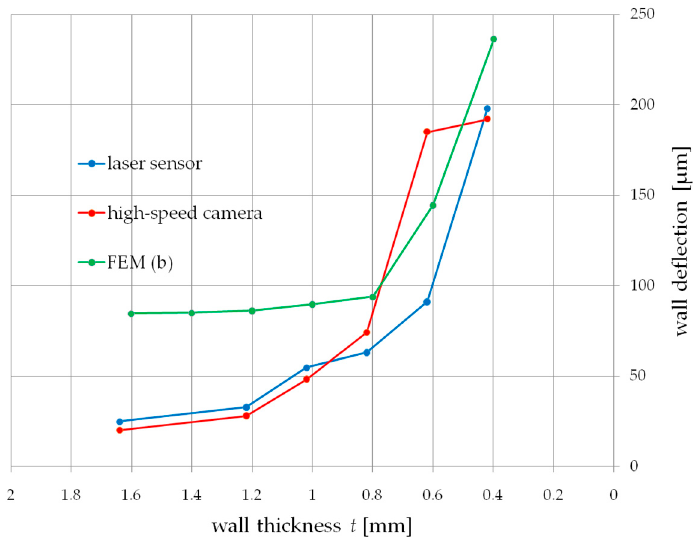
Figure 11. Finite element analysis—wall deflection under influence of the cutter, test b.